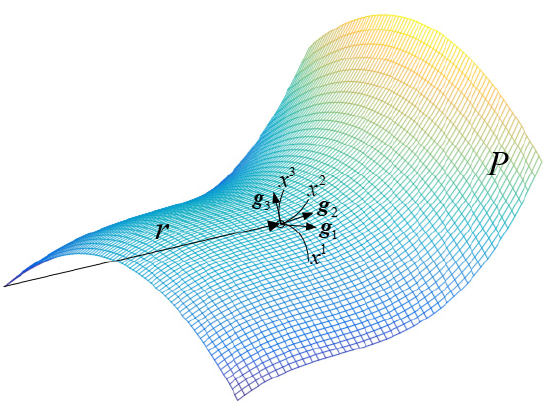
Figure 1. Schematic diagram of the component state-evaluation method based on tensor theory.